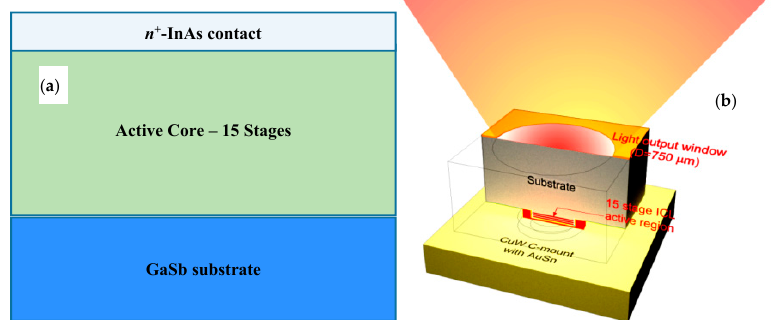
Figure 19. ( a ) Typical ICLED layering configuration (without grouped stages), where the active stages may be identical to those of an ICL; ( b ) schematic of the epitaxial-side-down mounted device, which emits through an annular bottom contact on the substrate side.